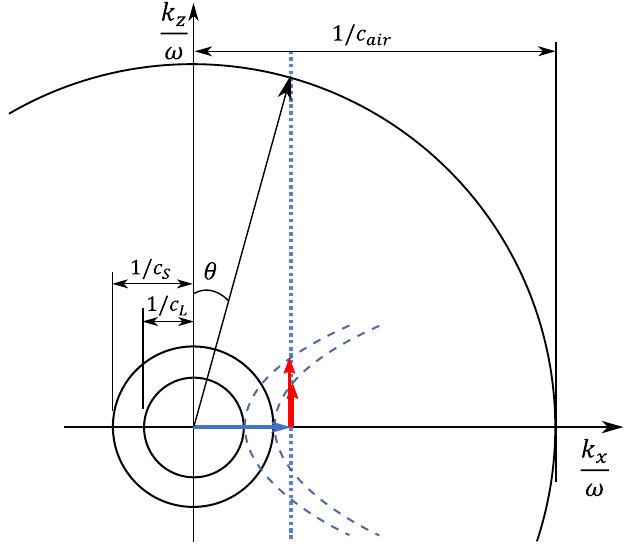
Figure 1. Schematic (not to scale) of how the slowness curves and Snell’s law can be used to characterize the direction in which the leaking wave (oblique pressure wave) is travelling. The black circles represent the bulk wave solutions (real-valued k z ) and the blue parabolas represent the evanescent wave solutions (imaginary-valued k z ).